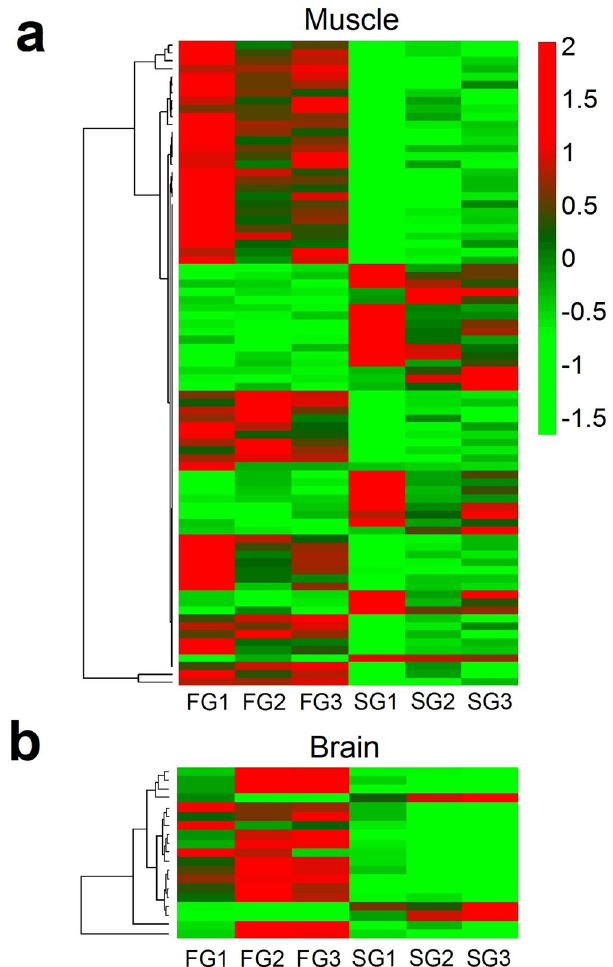
Figure 1. Muscle and brain heatmaps. Heatmaps of genes showing FDR corrected p-values < 0.3 for fast- (FG) and slow- (SG) growing turbot in: ( a ) muscle and ( b ) brain. Displayed are DESeq. 2 v.3.2 (Love et al . 59 ) normalized counts for each sample and gene scaled by gene. Genes were hierarchically clustered according to their gene expression using Pearson correlation as a distance